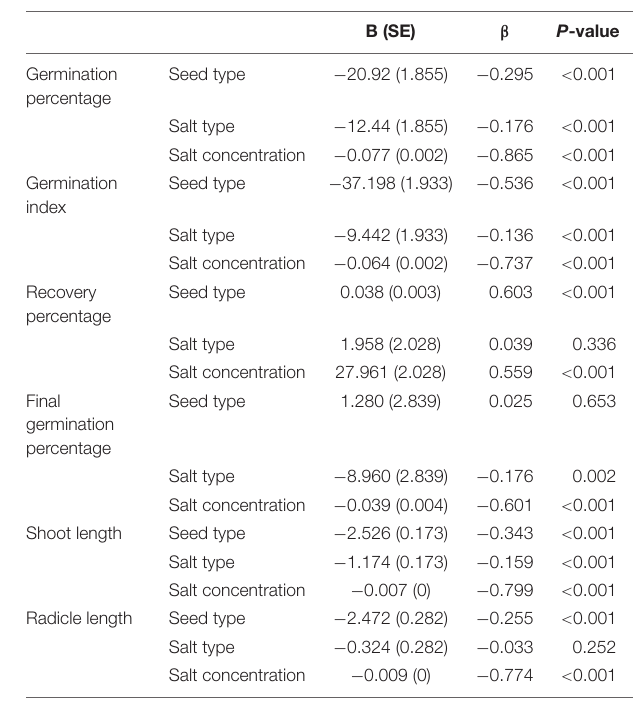
TABLE 1 | Multiple linear regression analysis of germination percentage, germination index, recovery percentage, and final germination percentage of dimorphic seeds, and radicle and shoot length of seedlings grown from dimorphic seeds of S. salsa